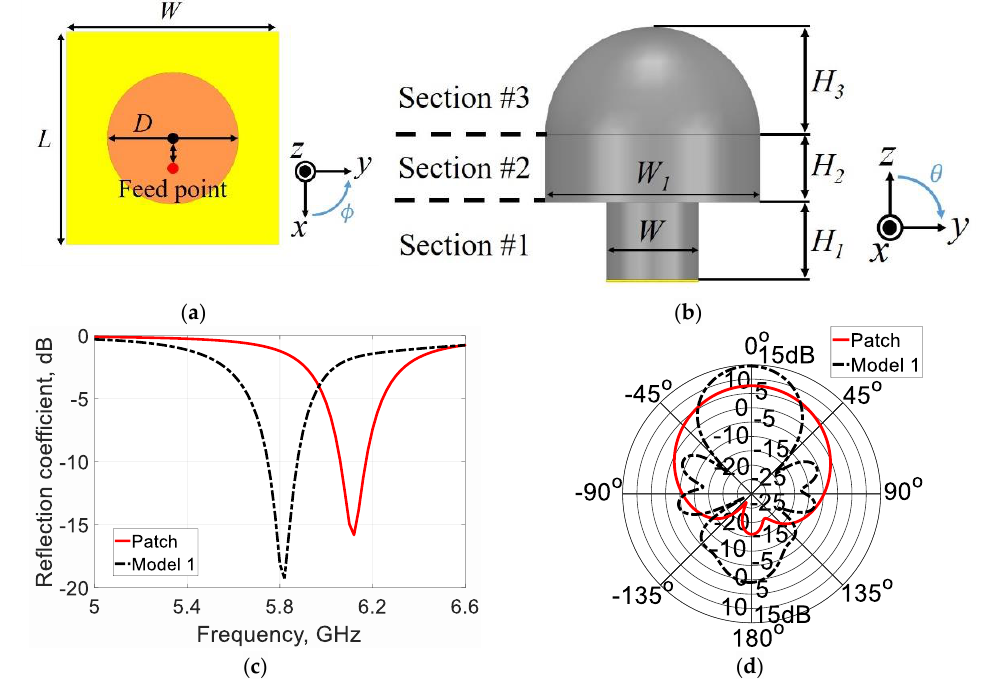
Figure 1. Reference lens antenna simulation. ( a ) Reference patch antenna. ( b ) Reference lens antenna (model 1). ( c ) Reflection coefficient. ( d ) 𝜃 -sweep radiation pattern ( 𝜙 = 0° ). The design parameters are W = 30, L = 30, D = 18.6, W 1 = 70, H 1 = 25, H 2 = 22, and H 3 = 35. All units are in millimeters.